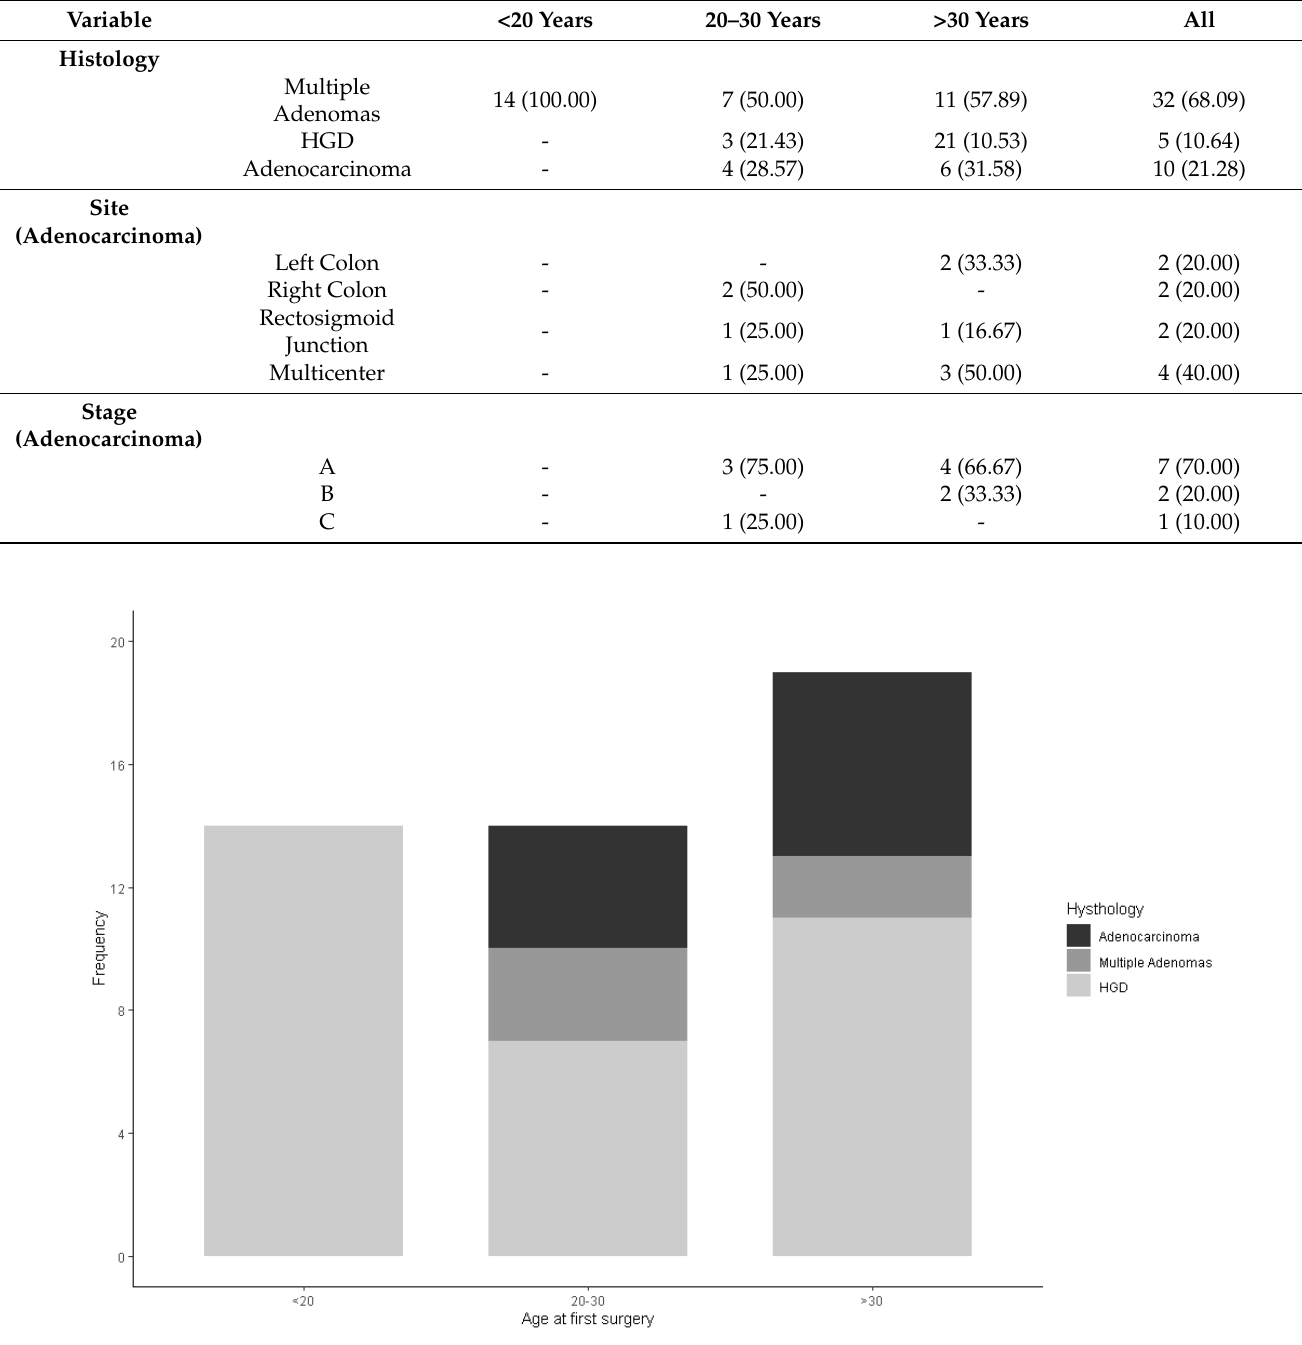
Table 2. Baseline surgical details.